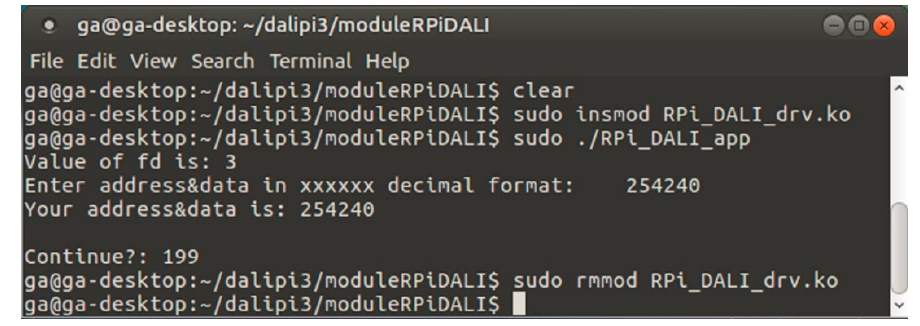
Figure 8. Console view of application execution.